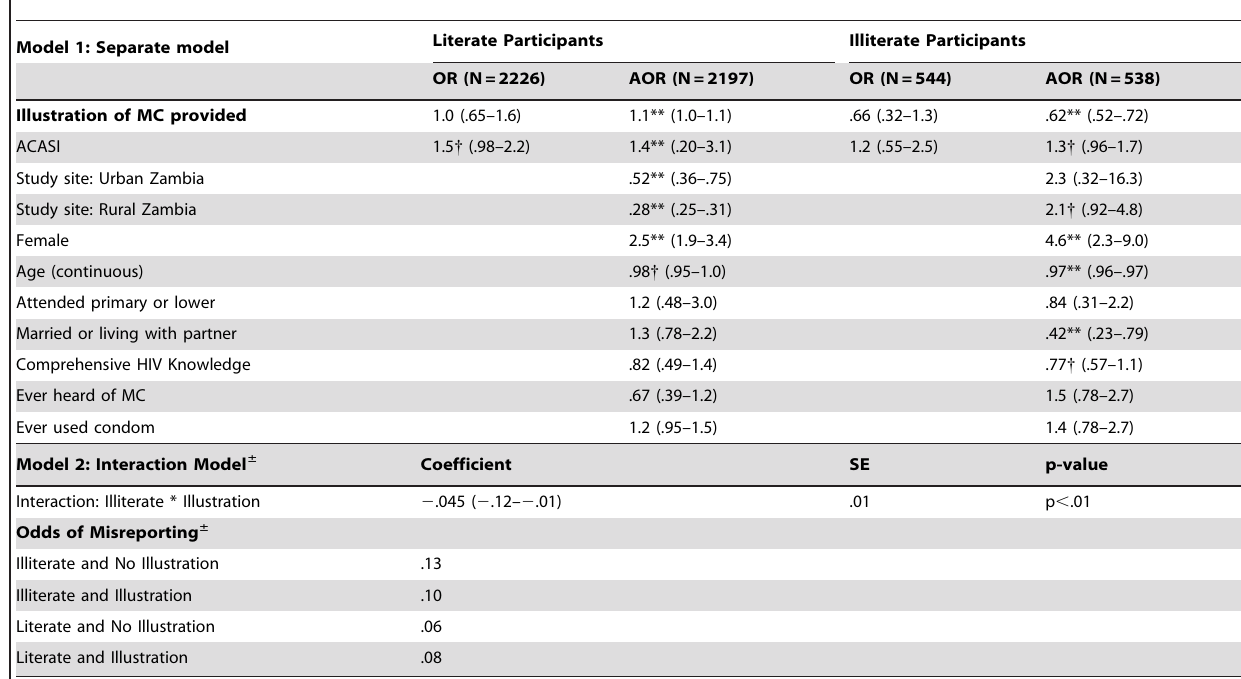
Table 4. Logistic regression on pooled data assessing illustration on misreporting of MC